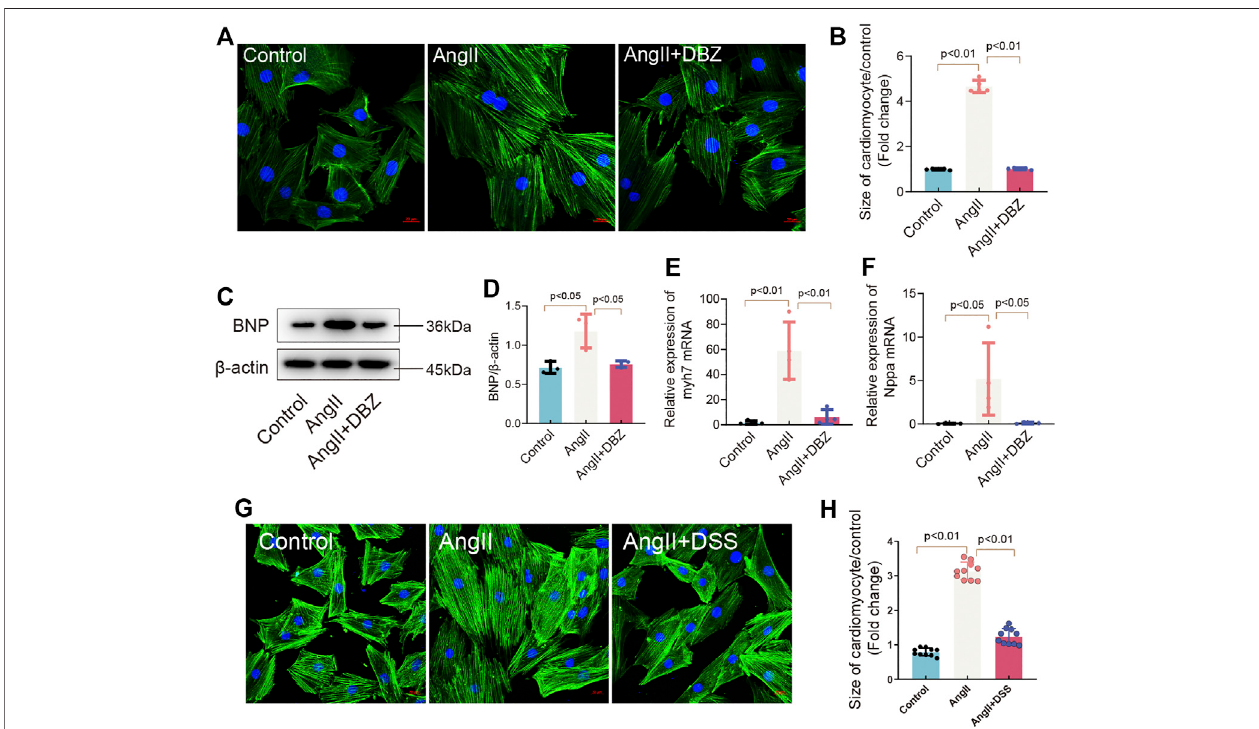
FIGURE2| DBZinhibited cardiomyocytehypertrophy. (A,B) RhodaminephalloidinstainingofNRCMs andquanti fi cationofthesizeofcardiomyocytes.Scalebars represent 20 μ m. n = 10. (C,D) Representative Western blotting assay and quanti fi cation ofBNPexpression. n =3. (E,F) Real-time PCR quanti fi cation of relative mRNA expression levelofmyh7andNppa. n =4. (G,H) RhodaminephalloidinstainingofNRCMs and quanti fi cation ofthesizeofcardiomyocytes.Scalebarsrepresent20 μ m. n = 10. Results are expressed as means ± SD. Statistical analyses were performed by one-way ANOVA followed by Bonferroni ’ s post-hoc